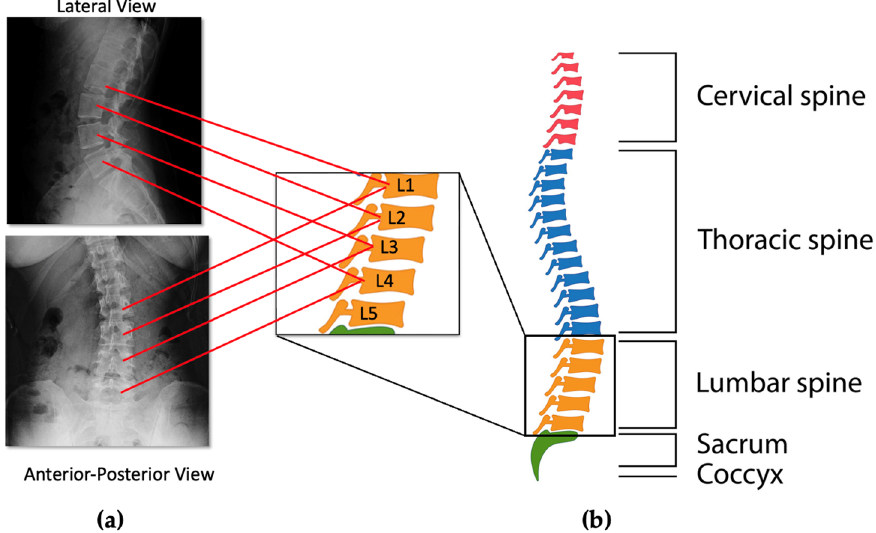
Figure 2. X-ray image of lumbar ( a ) and structure of human spine ( b ).